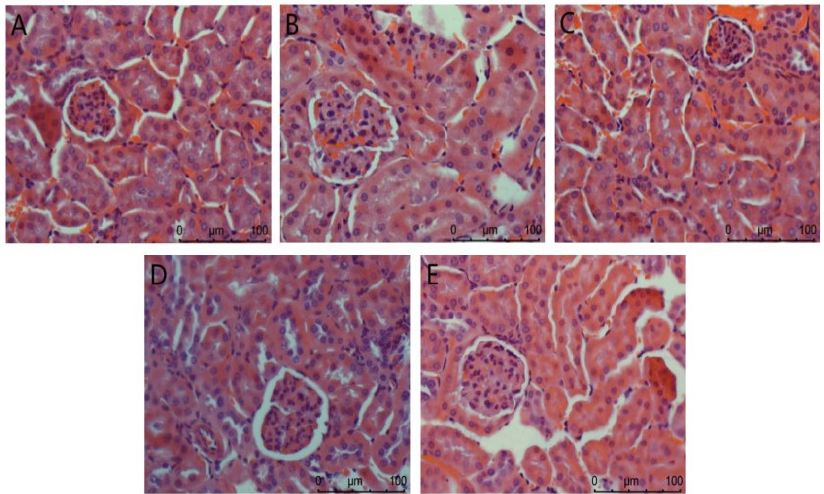
Figure 3. Nephridium biopsy analysis in mice. ( A ): Normal; ( B ) ： Model; ( C ): Positive control; ( D ): ACP low dose; ( E ): ACP high dose.